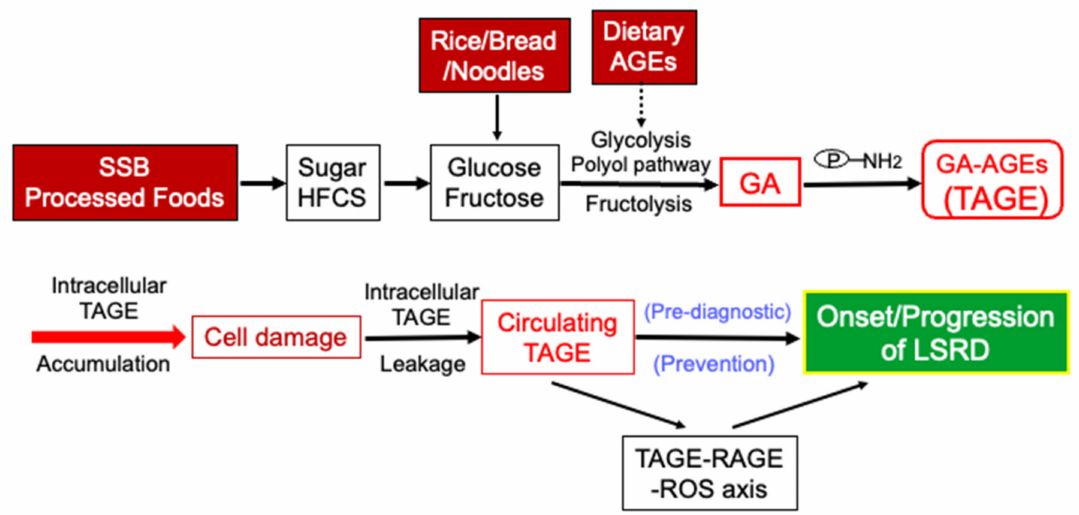
Figure 3. The onset and progression of lifestyle-related diseases (LSRD) are associated with the habitual excessive intake of sugars and/or dietary AGEs. TAGE are produced from the metabolite of glucose, the main component of rice, bread, and noodles, as well as the metabolites of sugars (sucrose and HFCS) added to beverages and processed foods. Fluctuations in TAGE levels in the human body are closely associated with dietary habits. The chronic intake of excessive amounts of SSB, processed foods, and/or rice/bread/noodles, which is characteristic of the modern daily diet, increases the cellular levels of the sugar metabolite glyceraldehyde (GA), which promotes the production of TAGE from intracellular proteins. Elevated levels of TAGE damage cells, which results in the leakage of TAGE into the circulation, thereby increasing circulating TAGE levels. Moreover, the habitual and excessive consumption of excessive dietary AGEs (mainly Glu-/Fru-AGEs) promotes the accumulation of TAGE and up-regulates the expression of RAGE, resulting in TAGE-RAGE interactions. Activation of the TAGE-RAGE axis leads to the production of ROS, which up-regulate the expression of RAGE and promote the generation of TAGE, which have been implicated in the onset and progression